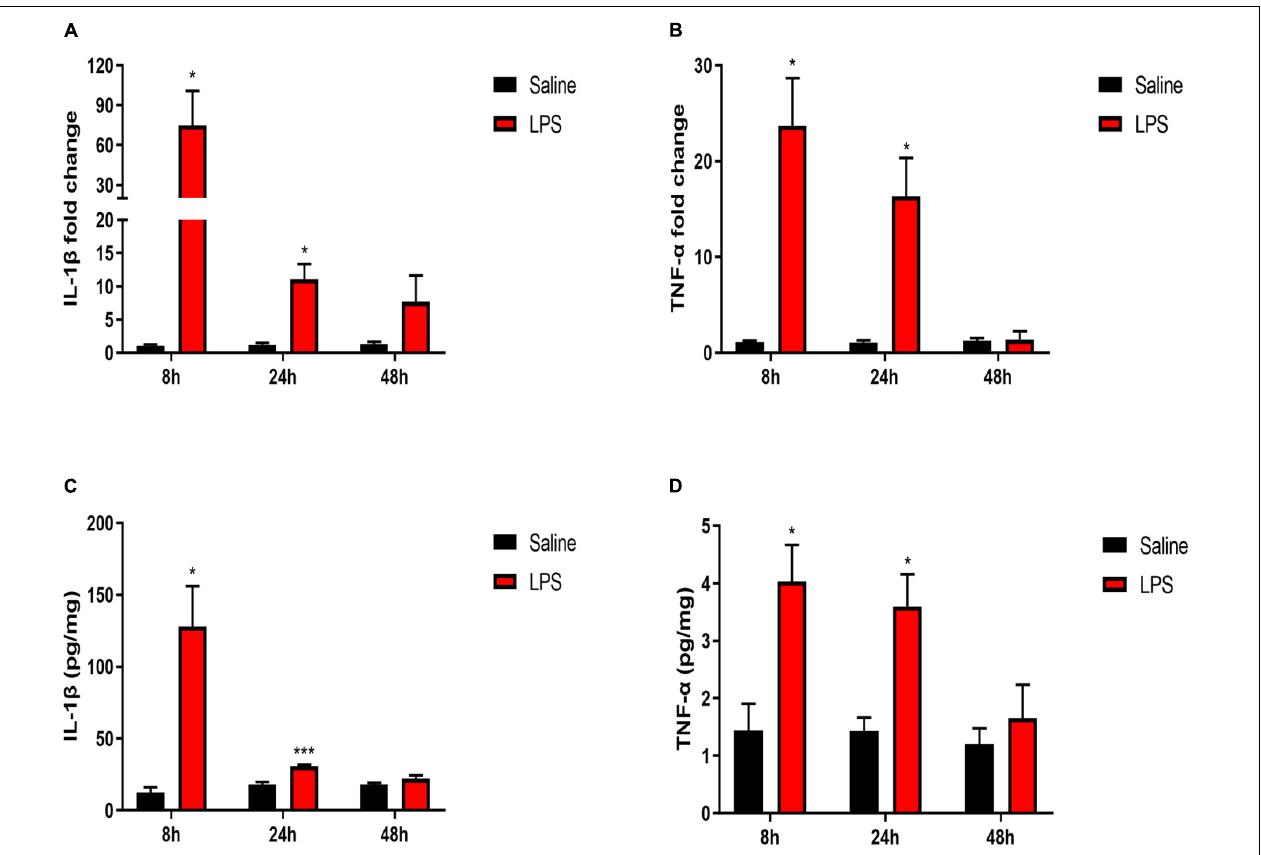
FIGURE 3 | LPS increased levels of pro-inflammatory cytokines in the spinal cord. (A,B) mRNA levels of IL-1 β and TNF- α were elevated 8 and 24 h after LPS injection in neonatal rats. (C,D) Protein expressions of IL-1 β and TNF- α were elevated 8 and 24 h after LPS injection in neonatal rats. Results are expressed as the mean ± SEM, n = 4–5 animals for each group, and were analyzed by unpaired t -test or Mann–Whitney test. * P < 0.05, *** P < 0.001 LPS group vs. Saline